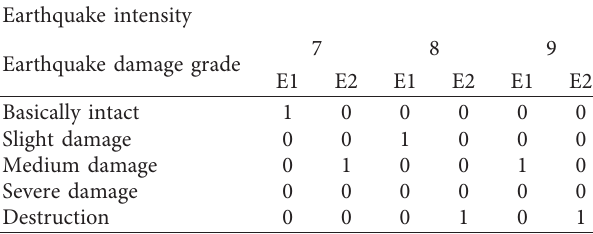
Table 13: Seismic damage prediction matrix of the bridge (according to reference